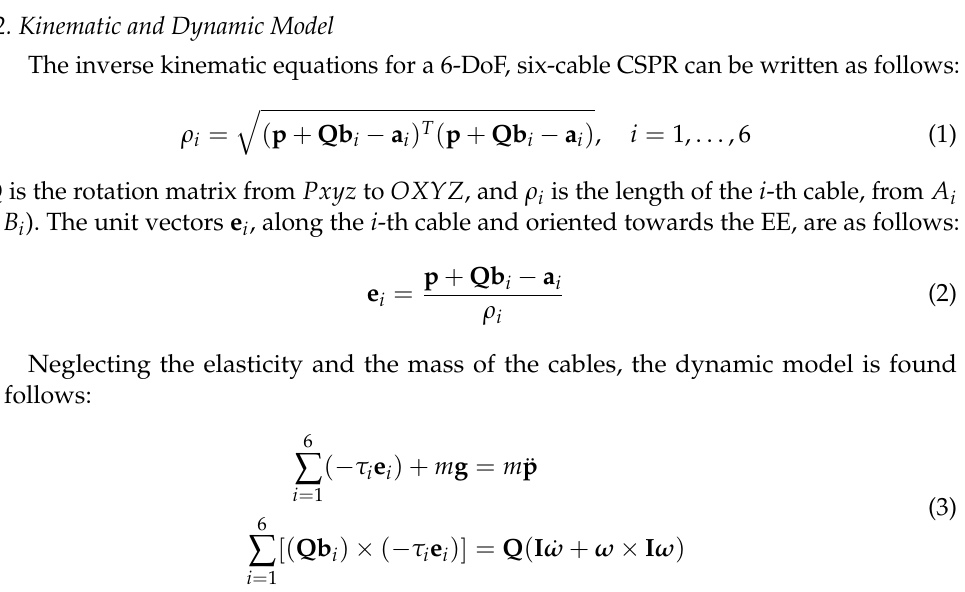
Figure 4. The parallelogram defined by cables 5 and 6; the fixed and mobile frames are also